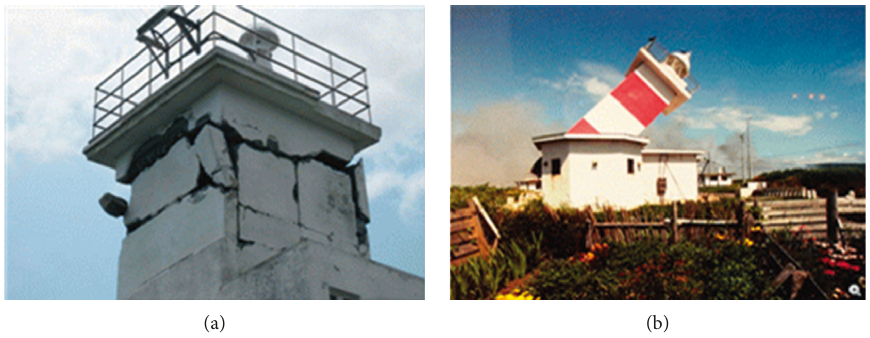
Figure 1: Earthquake damage of lighthouse (Tohoku Region Pacific Coast Earthquake, 2011).